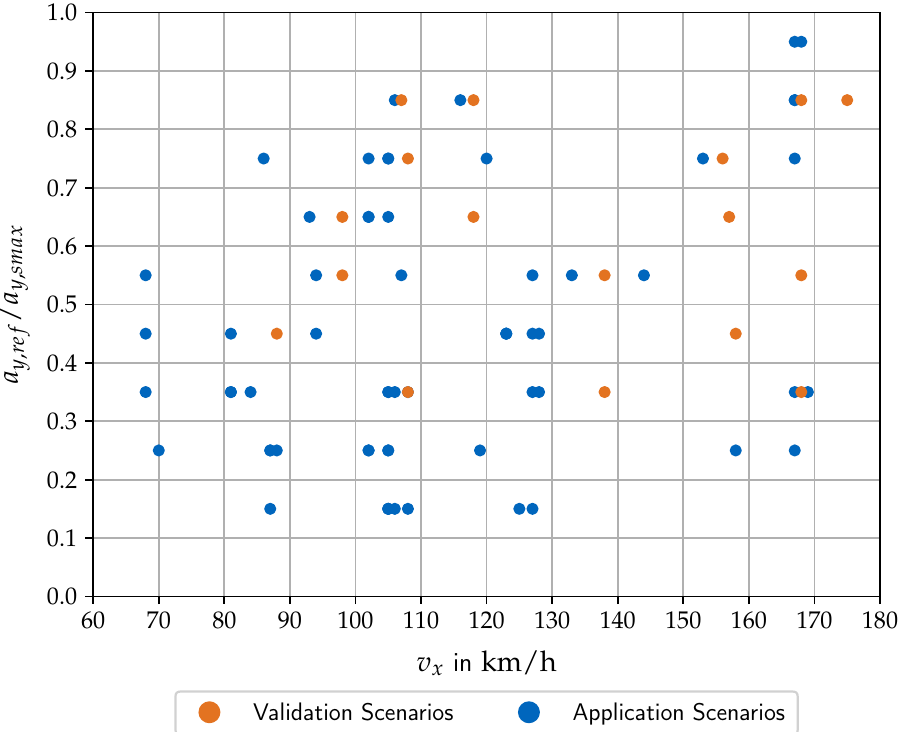
Figure 4. Coverage-based validation scenarios and data-driven application scenarios. The 2D grid cells are used by the coverage-based algorithm. The data-driven algorithm uses only the acceleration grid and has contiguous velocities with a maximum resolution of